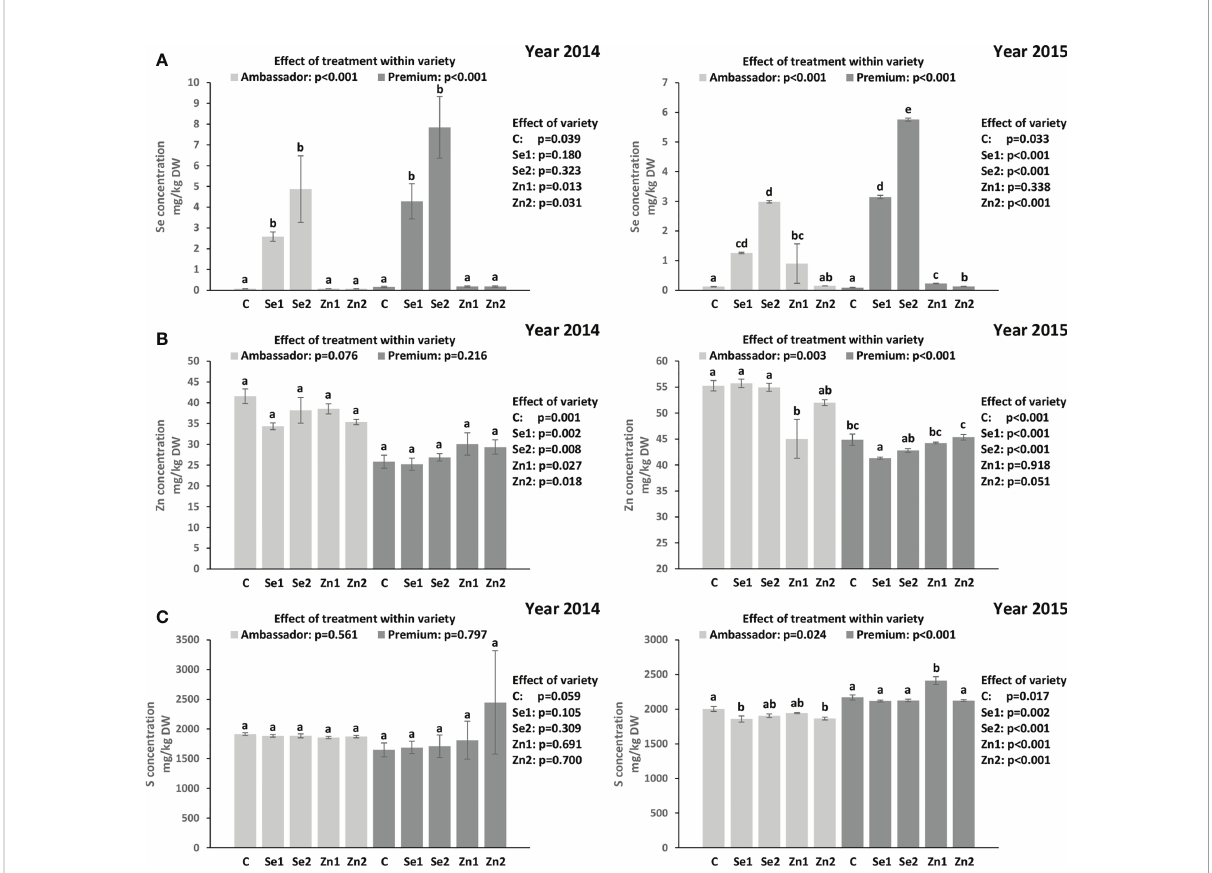
FIGURE 1 Effect of foliar Se and Zn treatments and variety in two growing seasons (2014 and 2015) on the Se concentration (A) , Zn concentration (B) , and S concentration (C) in pea seeds. Control: without Se/Zn; Se1: 50 g of Se/ha; Se2: 100 g of Se/ha; Zn1: 375 g of Zn/ha; Zn2: 750 g of Zn/ha; mean ± SD; n = 4. Bars not sharing the same superscript are signi fi cantly different within variety. p -values on the right side of the fi gure show the effect of treatment across the two varieties (i.e., Ambassador vs.